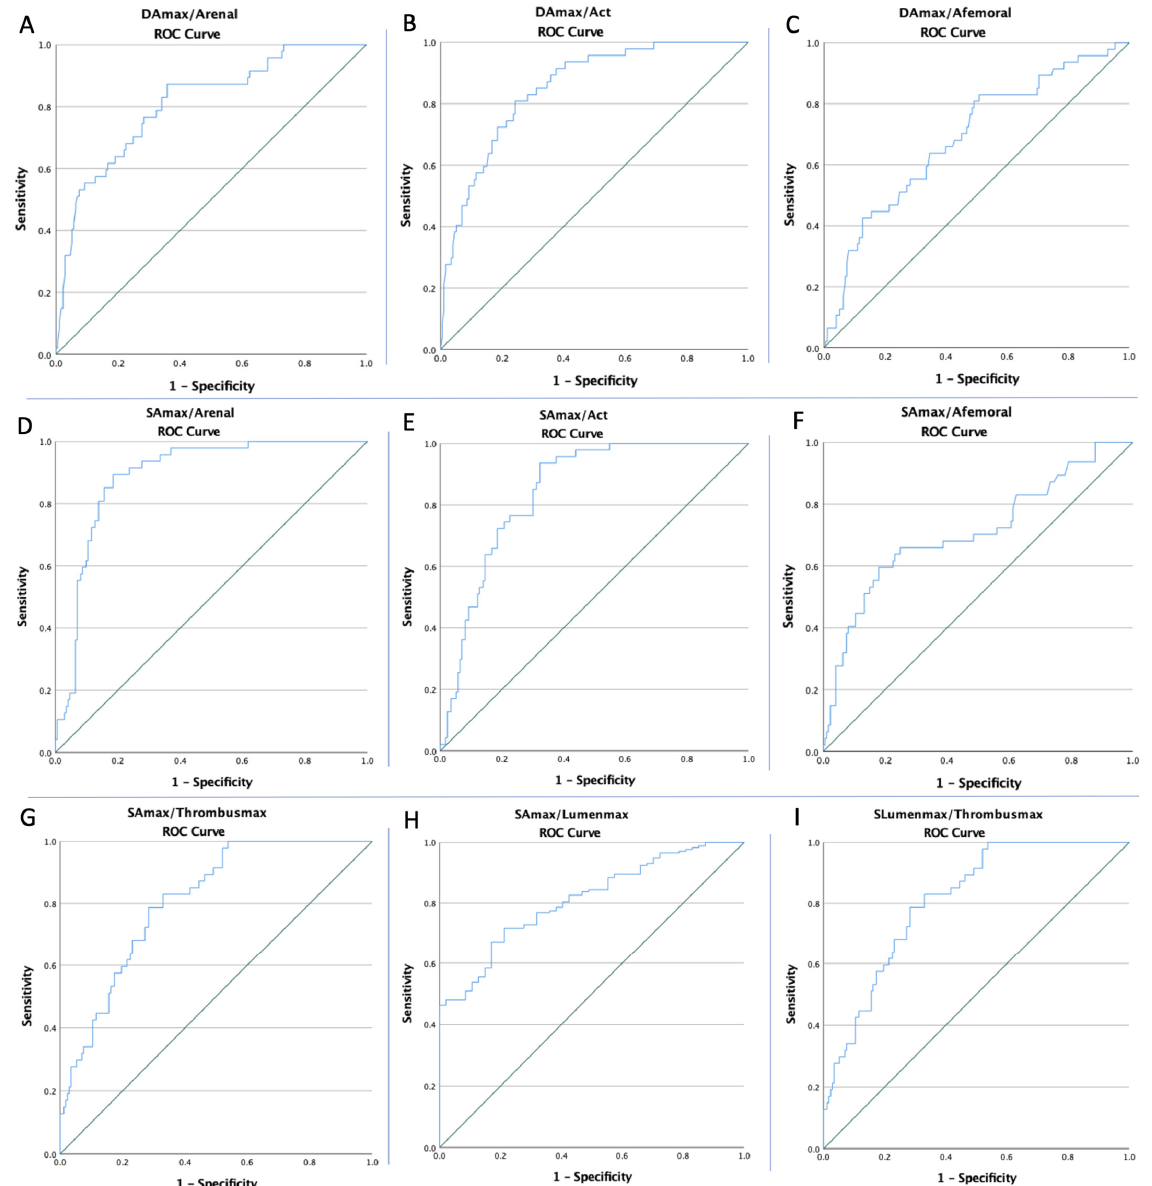
Figure 3. The ROC curve analysis concerning AAA rupture for the ( A ) DA max /A renal (AUC: 0.810; p < 0.0001), ( B ) DA max /A CT (AUC: 0.850; p < 0.0001), ( C ) DA max /A femoral (AUC: 0.687; p < 0.0001), ( D ) SA- max /A renal (AUC: 0.890; p < 0.0001), ( E ) SA max /A CT (AUC: 0.846; p < 0.0001), ( F ) SA max /A femoral (AUC: 0.709; p < 0.0001), ( G ) SA max /Thrombus max (AUC: 0.809; p < 0.0001), ( H ) SA max /Lumen max (AUC: 0.809; p < 0.0001), and ( I ) SLumen max /Thrombus max (AUC: 0.809; p < 0.0001).